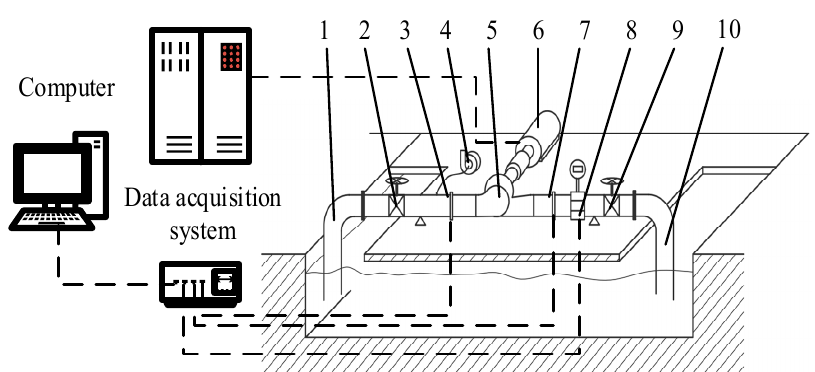
Figure 4. Scheme of the test rig. 1: Inlet pipe, 2(9): Valve, 3(7): Pressure transducer, 4: Vacuum pump,